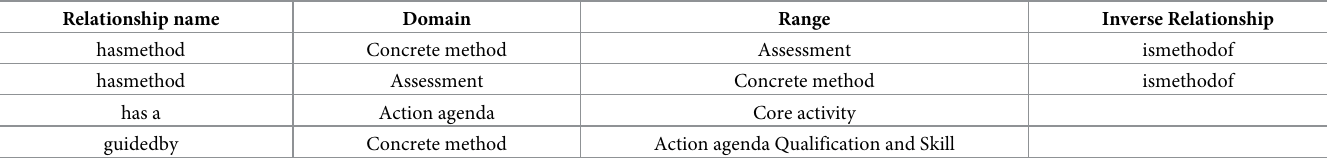
Table 2. Relationship design of psychological first aid ontology.